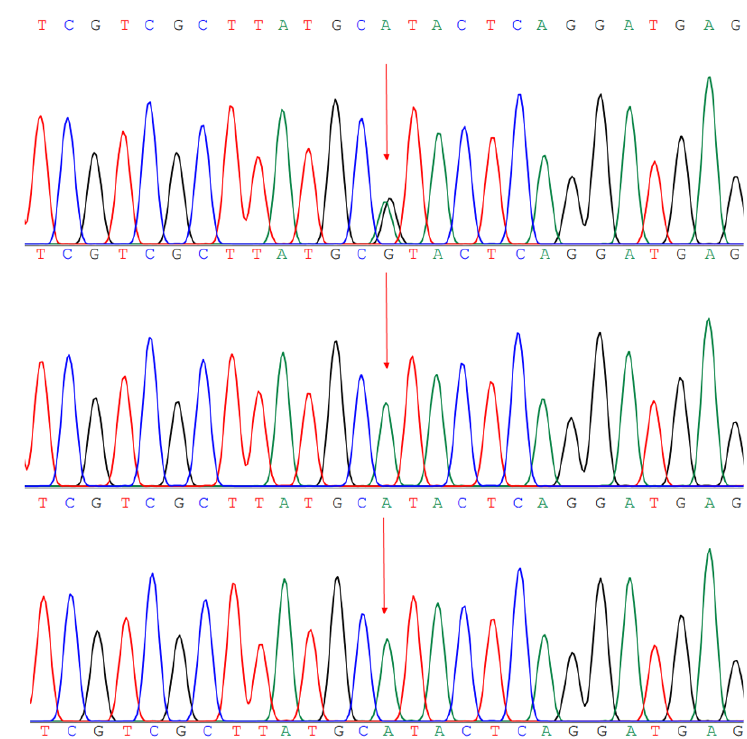
Fig. 1 - Sequencing results of the SMAD4 mutation. Gene